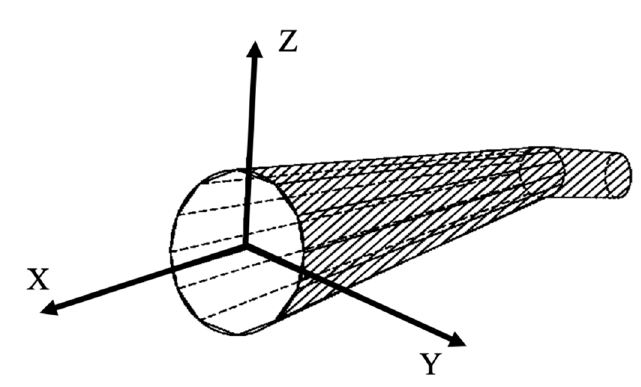
Figure 1. Local coordinate system of pipe section.